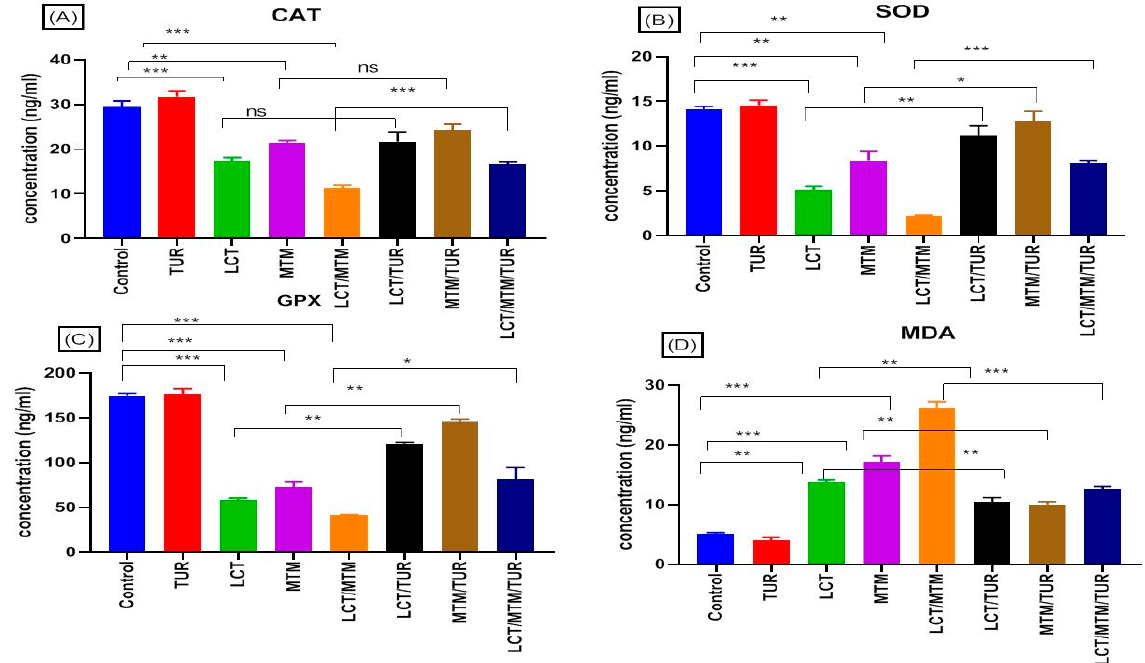
Figure 2. Changes in catalase (CAT), superoxide dismutase (SOD), and glutathione peroxidase (GPX), activities in the serum and the serum concentration of malonaldehyde (MDA) of O. niloticus after exposure to LCT and/or MTM (1/20 of LC50) and a diet containing 1% taurine (TUR) for 60 days. The values are shown as means ± SEs. One-way ANOVA was followed by Tukey’s post hoc tests to measure the significance of differences between groups. *— p ≤ 0.05 (low significance); **— p ≤ 0.01 (moderate significance); ***— p < 0.001 (highly significant difference). The comparisons are represented in the figure as follows: LCT versus LCT + TUR, MTM versus (MTM + TUR), and LCT + MTM versus LCT + MTM +TUR.